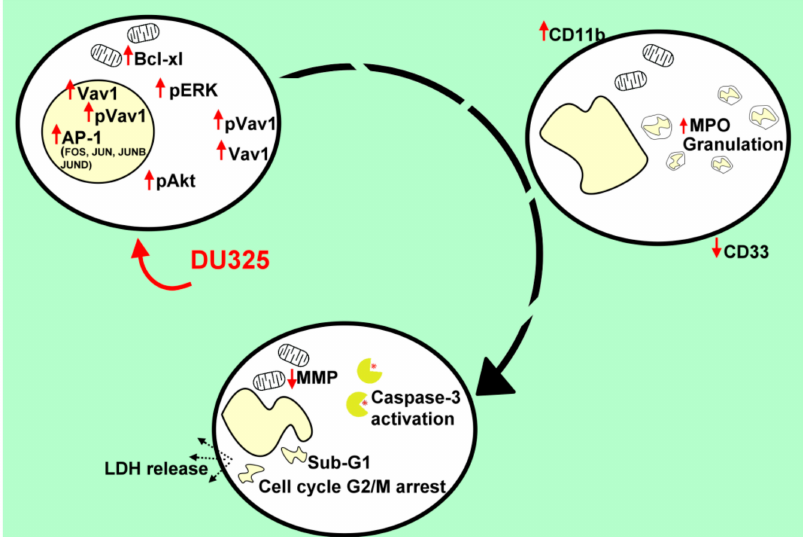
Figure 10. The series of events followed after the treatment of HL-60 cells with DU325. We obtained ERK phosphorylation as an early survival response to treatment followed by the increase of the percentage of the Bcl-xl bright and pAkt bright cells. The induction of Vav1, pVav1, and the AP-1 complex is a driver of cellular di ff erentiation; FOS, JUN, JUNB, and JUND were elevated on a concentration and time-dependent manner. As a proof of granulocytic di ff erentiation, the cells remained nonadherent and the expression of CD33 decreased; the granularity, CD11b expression, and MPO activity of HL-60 cells increased upon treatment. Finally, viability of HL-60 cells was hampered shown by the depolarization of mitochondria, activation of caspase-3, G2 / M cell cycle arrest, appearance of the sub-G1 population, and the leakage of the lactate-dehydrogenase into the